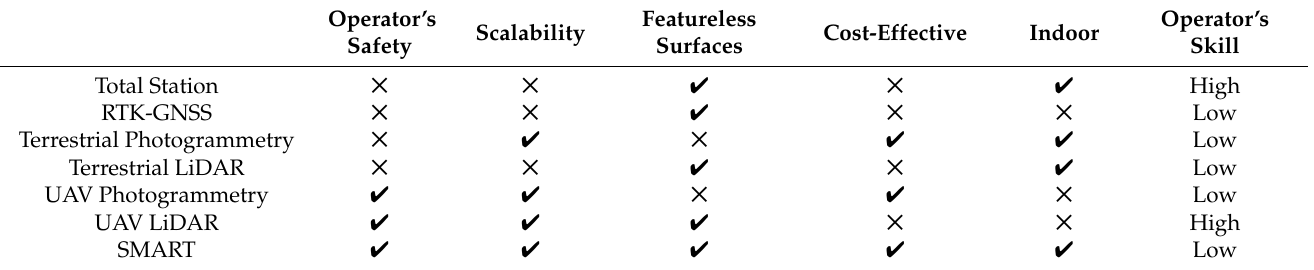
Table 1. Summary of pros and cons of current mapping/surveying techniques along with the proposed SMART for routine stockpile